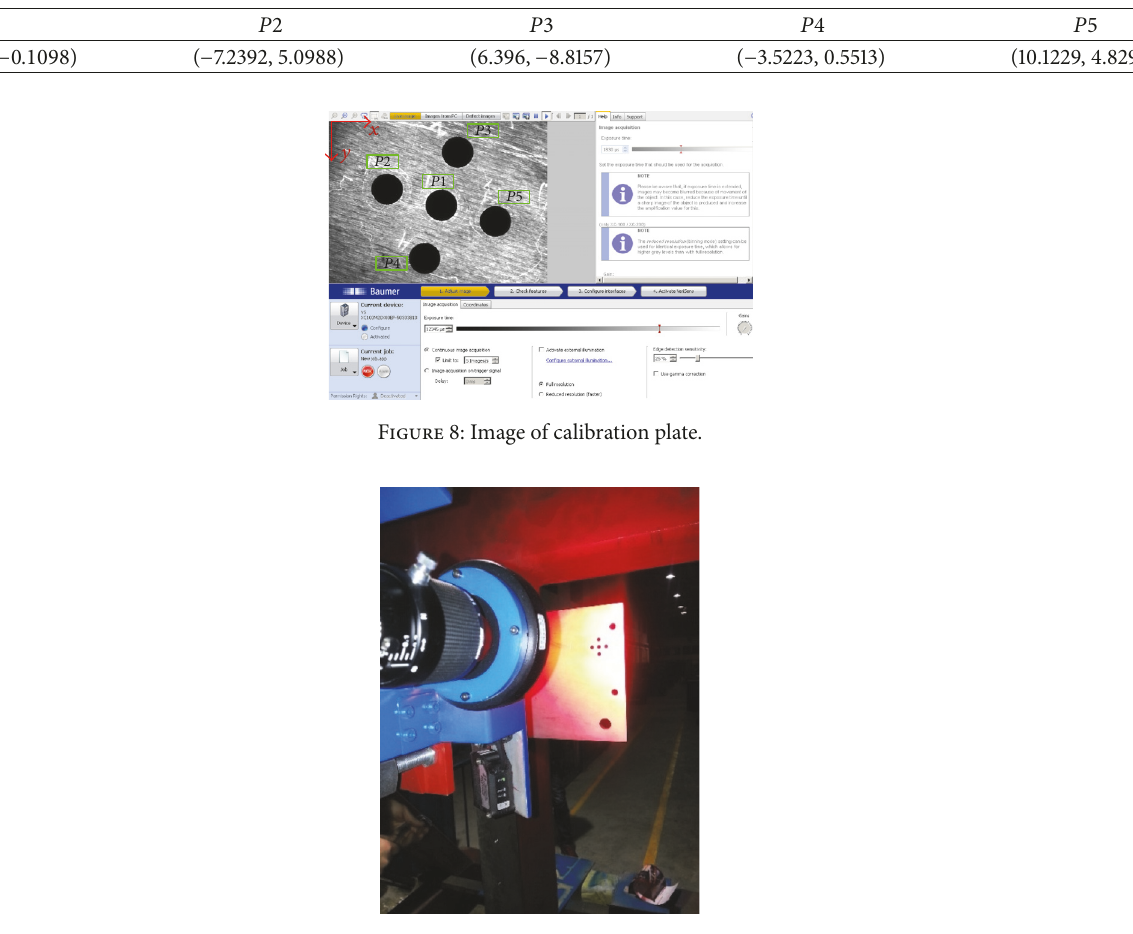
Figure 9: Direction calibration of industrial